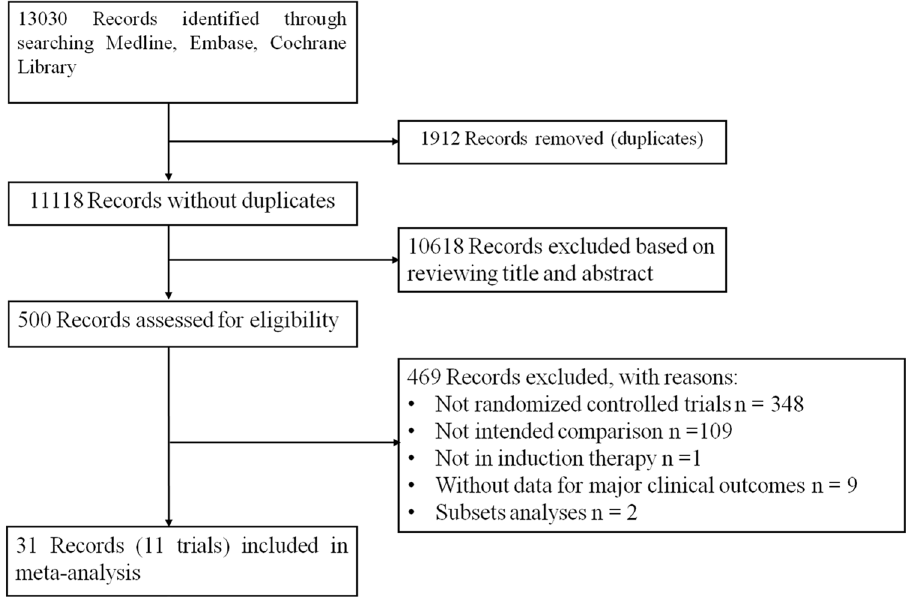
Figure 1. Flow chart of study selection. The PRISMA flow chart depicting study screening and